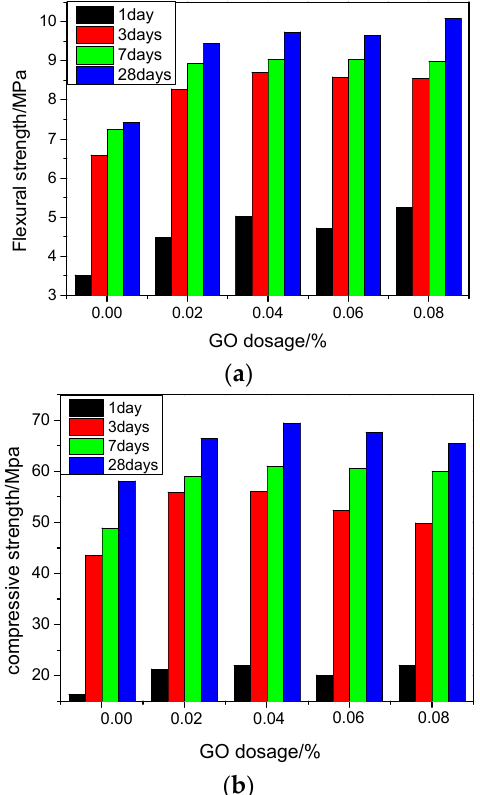
Figure 3. Flexural and compressive strengths of GO cement samples. ( a ) Flexural strength; ( b ) compressive strength.